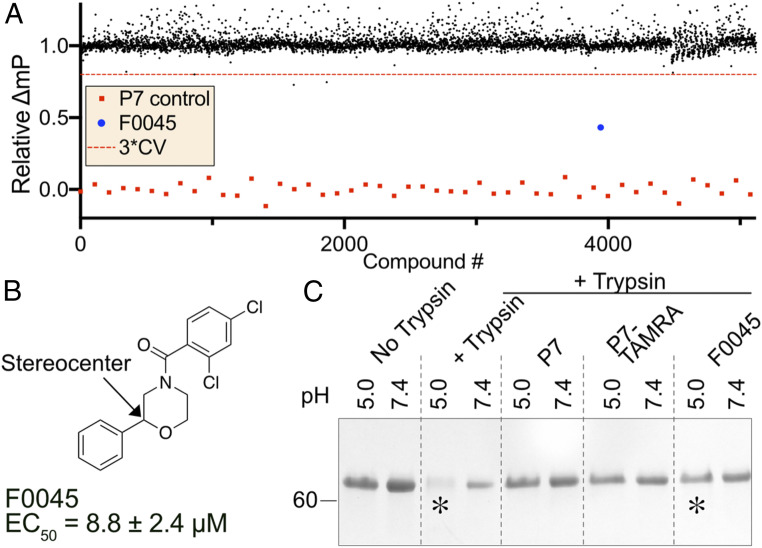
HTS for H1/PR8 and hit confirmation. (A) Scatter plot representation of 15 384-well plates in HTS with F0045 shown in blue. Black dots represent the number of compounds screened and red dots represent a peptide P7 control (coefficient of variation [CV]). (B) Chemical structure of the best hit F0045 from the HTS campaign. (C) Sodium dodecyl sulfate polyacrylamide gel electrophoresis (SDS-PAGE) analysis of the TS assay of 5-μM H1/PR8 HA incubated with 50-μM P7, P7-TAMRA probe, or F0045 with DMSO as a negative control. F0045 protects against trypsin degradation at pH 5.0 in comparison to the DMSO control (*).